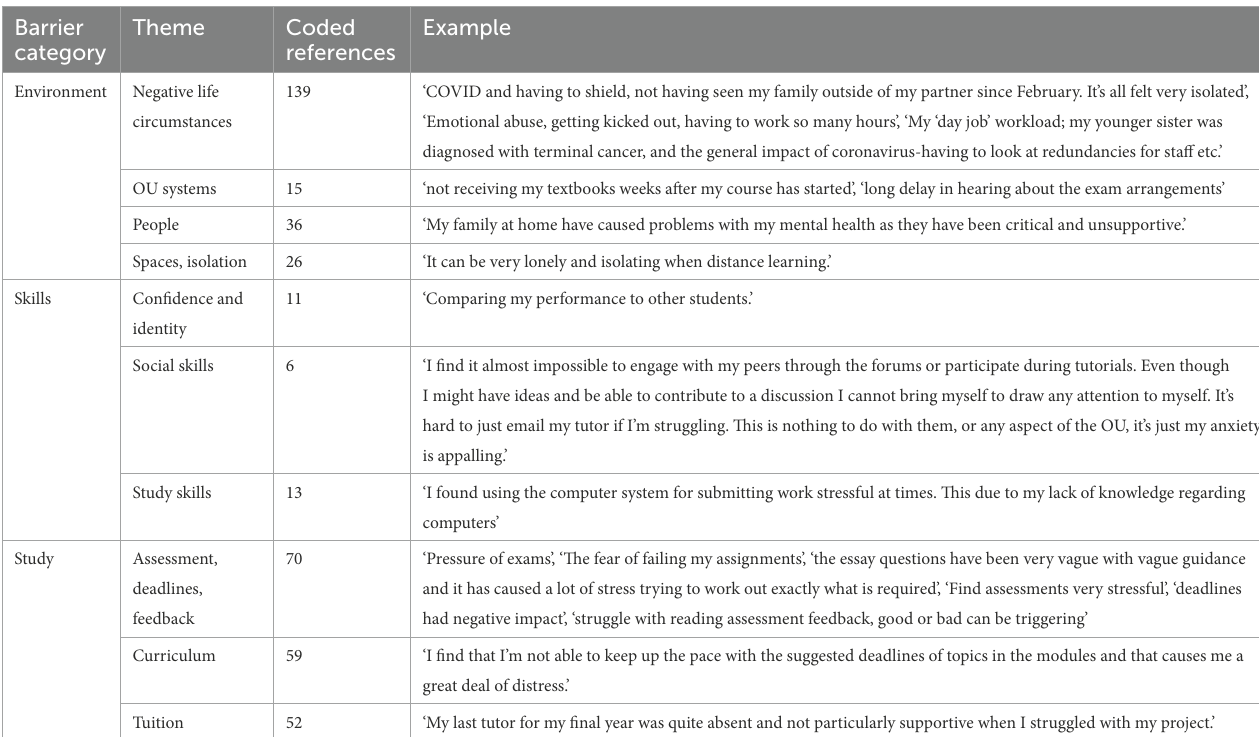
TABLE 3 Open comments referring to barriers.